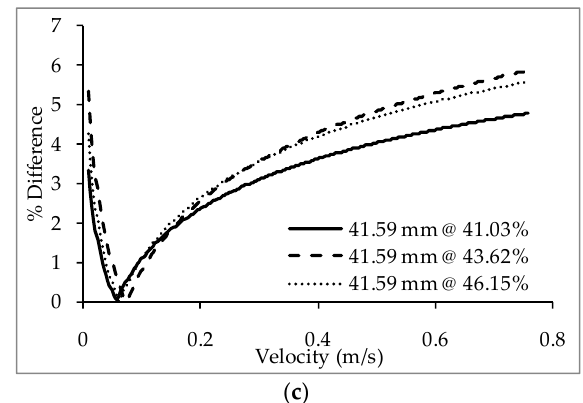
Figure 12. The variation of the percentage deviation between the experimental and simulation results with flow velocities for ( a ) 29.8 mm; ( b ) 34.78 mm; and ( c ) 41.59 mm media.